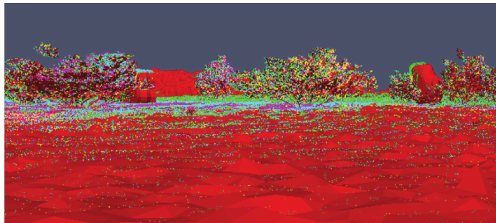
Figure 5: Side view of the simulated scene (see Figure 4 for color scheme details).